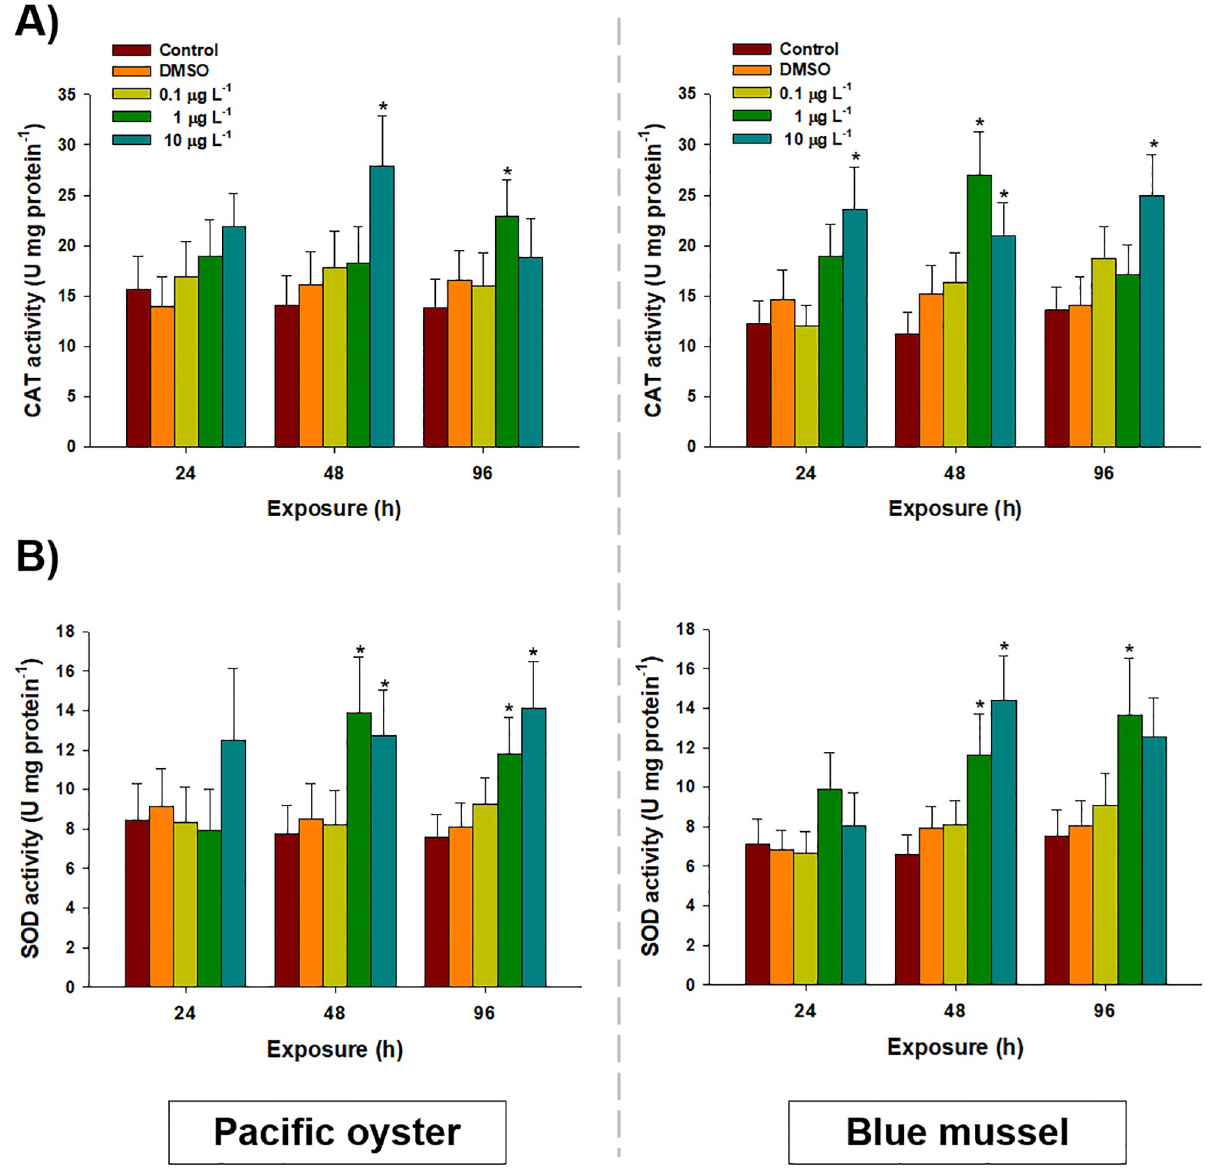
Fig 2. Effects of waterborne chlorothalonil on enzymatic oxidative stress parameters of marine bivalves. Effects of different concentrations of chlorothalonil (0.1, 1.0, and 10.0 μ g L -1 ) on (A) catalase (CAT) and (B) superoxide dismutase (SOD) levels in the gill tissues of Pacific oysters ( Crassostrea gigas) and blue mussels ( Mytilus edulis) over 96 h. Data are expressed as the mean ± standard deviation (S.D.). An asterisk ( � ) indicates significant differences compared to the control ( P <